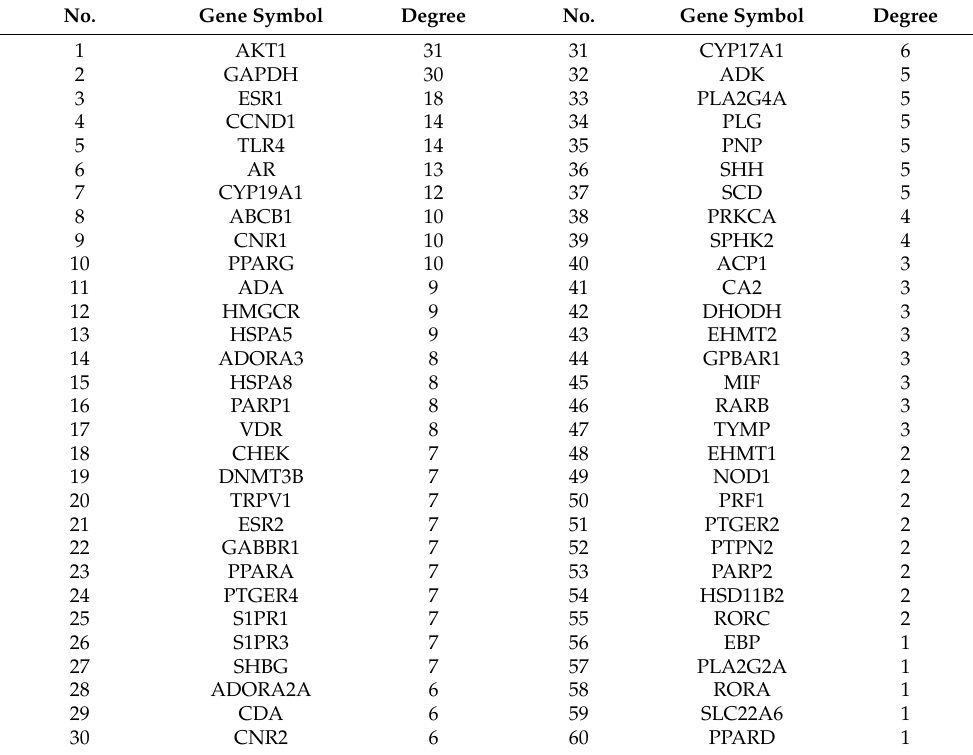
Table 3. The degree value of 60 target proteins.